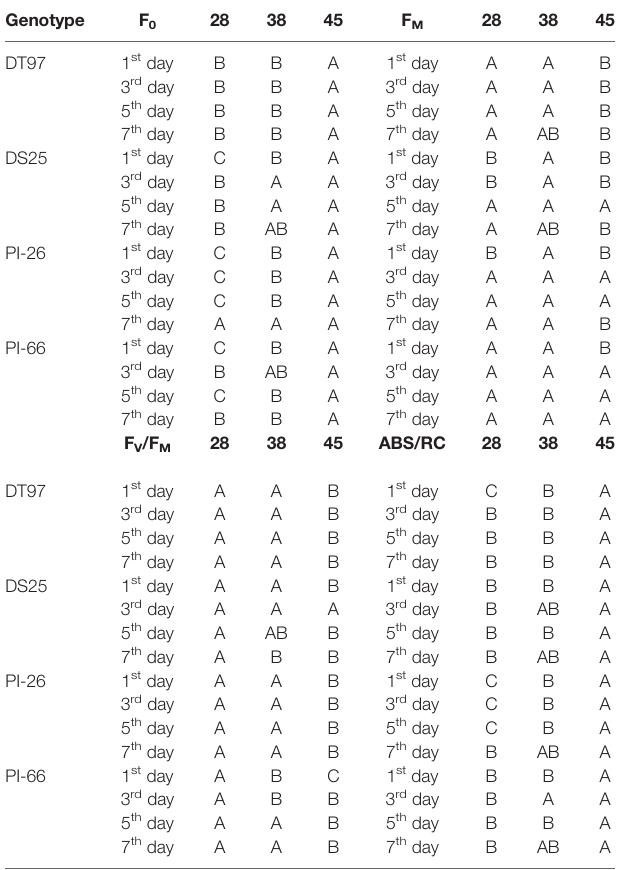
TABLE 2 | Statistical groupings for traits from Figure 3 .